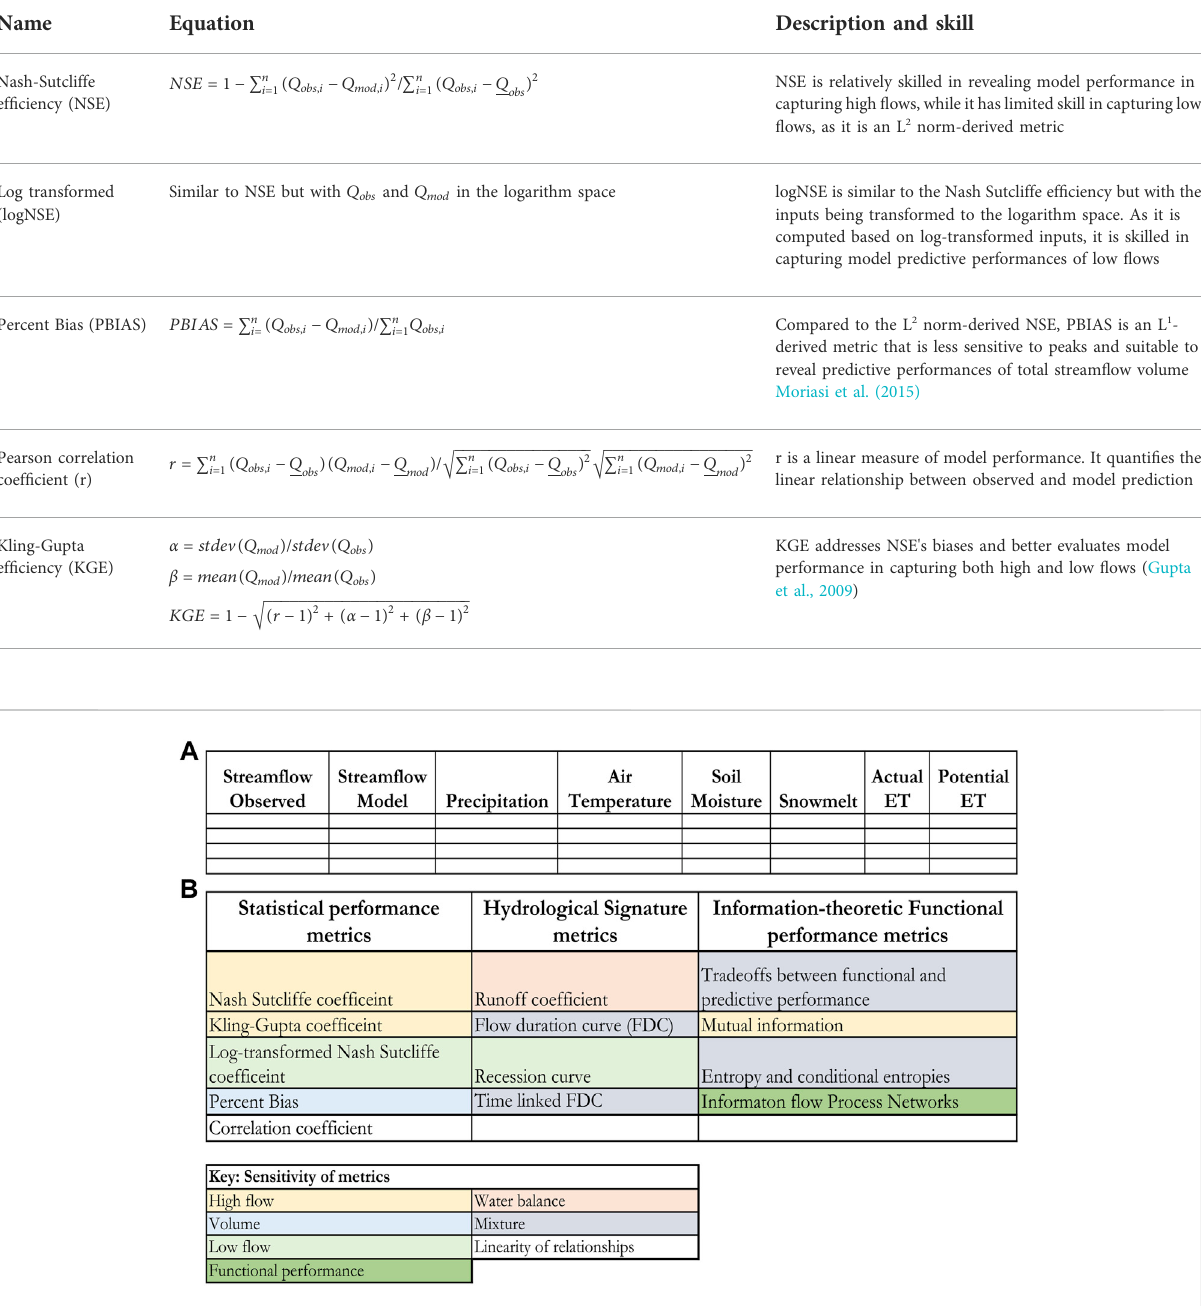
FIGURE 2 (A) Example of a standard input table to HydroBench. The empty cells refer to user provided input data, and (B) Summary of the output metrics of HydroBench and their sensitivities (color-coded). Color codes, described in the lower table ( “ Key: sensitivity of metrics ” ) indicate the hydrological feature to which the metric is most